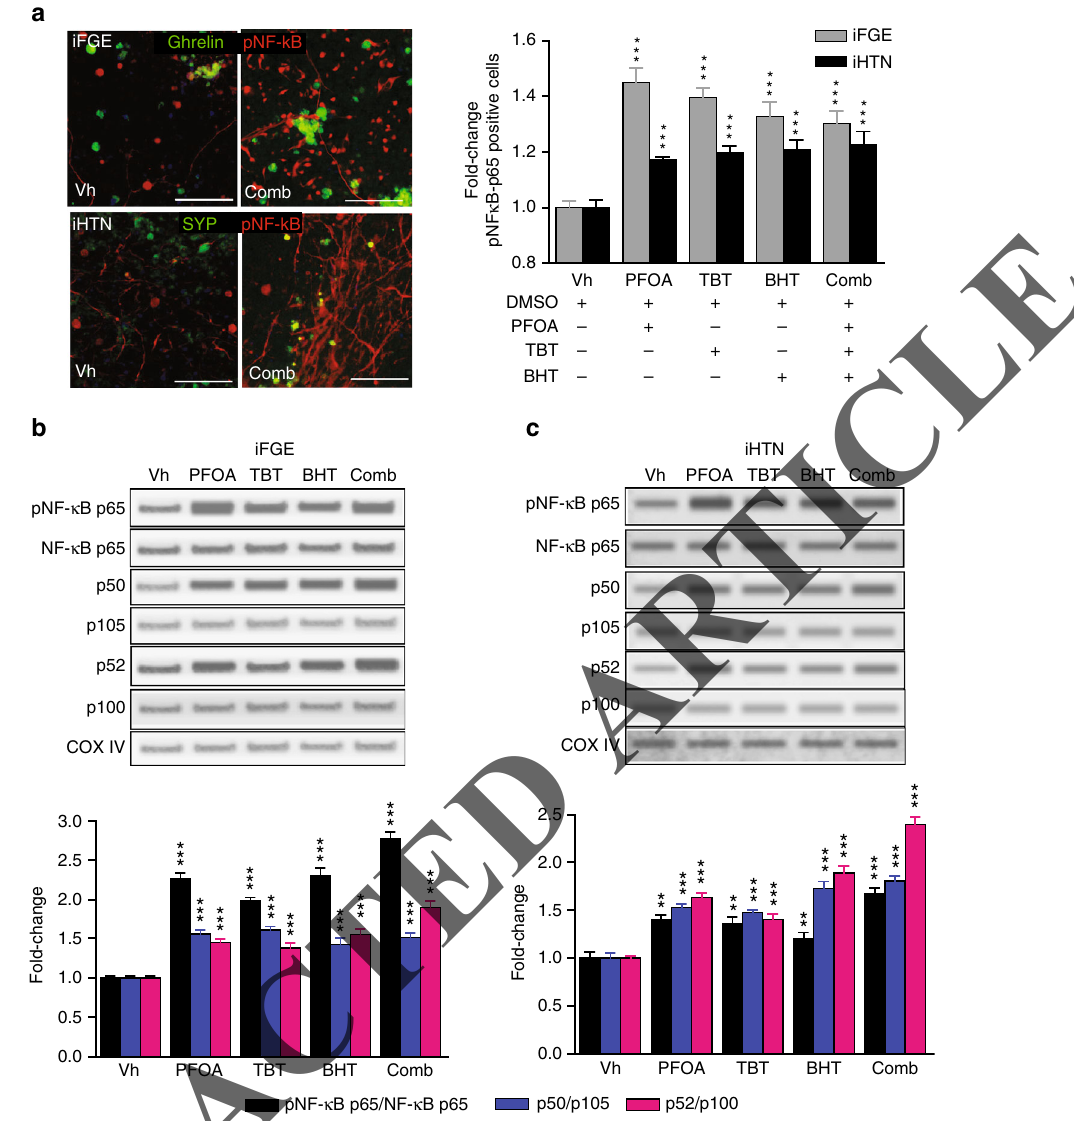
Fig. 4 EDC treatment causes disturbances in NF- κ B p65 canonical and non-canonical pathways. a Top panel : representative immunocytochemistry ( ICC ) showing increases in phosphorylated p65 ( red ) in iFGEs co-stained with ghrelin ( green ). Bottom panel : representative ICC showing increases in phosphorylated p65 ( red ) in iHTNs co-stained with synaptophysin ( green ) (*** p < 0.001). Immunopositive cells were scored and quanti fi ed in histograms for both iFGEs and iHTNs, which is represented by fold-change in phosphorylated NF- κ B p65 immunopositive cells in each of the EDC treatments compared with the vehicle control-treated iFGEs (*** p < 0.001) and iHTNs (*** p < 0.001). Representative immunoblots for protein levels in whole-cell lysate showing increases in phosphorylated p65, total p50, and total p52 levels in b iFGE, *** p < 0.001 and c iHTNs *** p < 0.001. Quanti fi ed histograms using ImageJ-based densitometry of bands for each of the respective immunoblots are shown below and represented as fold-change compared with vehicle-treated control. Ratio of phosphorylated NF- κ B p65 over total p65, p50/105 (canonical), and p52/p100 (non-canonical) were calculated. All statistical analyses were performed using one-way ANOVA. Images and data shown here are representative of average results from the two iPSC lines differentiated n = 3 times in independent experiments. Scale bars represent 50 µ m. Error bars denote